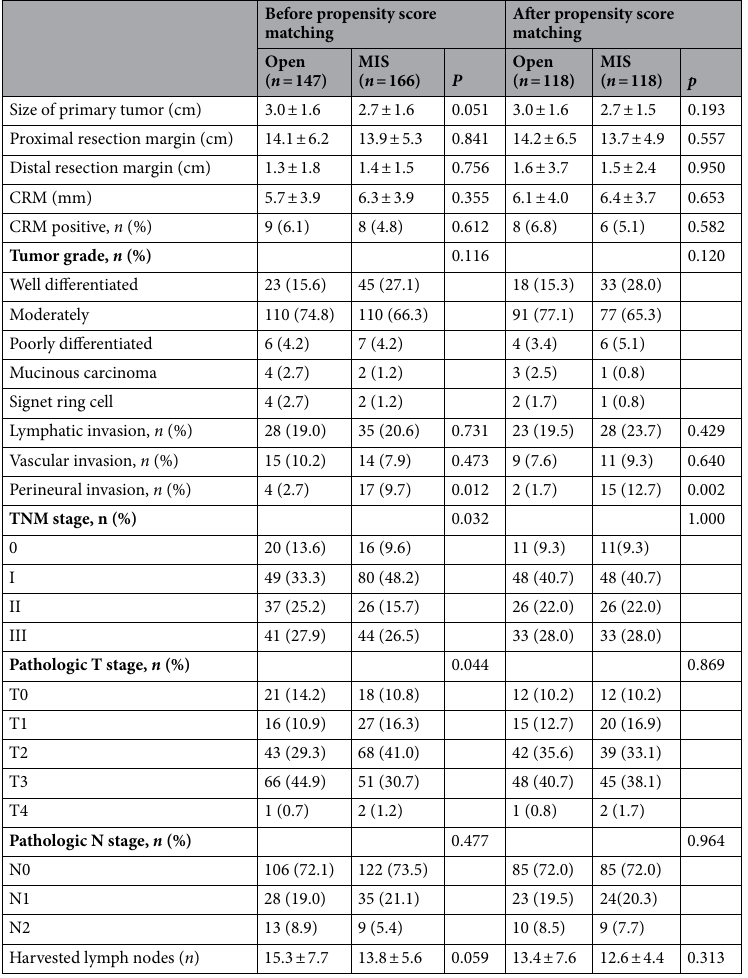
Table 4. Pathologic characteristics of patients treated with and without nCRT. nCRT neoadjuvant chemoradiotherapy, MIS minimally invasive surgery, CRM circumferential resection